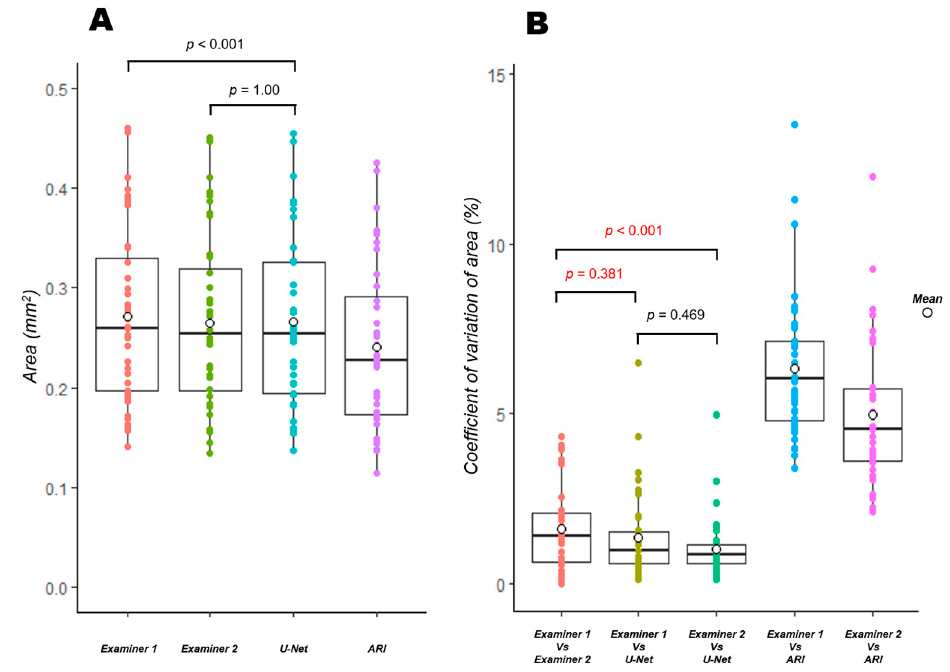
Figure 3. Multiple comparisons of the FAZ area and its coefficient of variation obtained by each extraction method. Results of the FAZ area ( A ) and the coefficient of variation of area ( B ) obtained by each extraction method. Comparing each combination of the four extraction methods, significant differences ( p < 0.001) were found for all of those without a p -value listed. Moreover, the area obtained by U-Net is significantly different from examiner 1 ( p < 0.001), but not from examiner 2 ( A ). ( p = 1.00). The CV of the area between examiner 1 and the U-Net is not significantly different from that between the manual methods ( p = 0.381), and the CV of the area between examiner 2 and the U-Net is significantly better than that between the manual methods ( B ). ( p < 0.001). The Bonferroni correction was used to adjust the p -value. FAZ: foveal avascular zone.